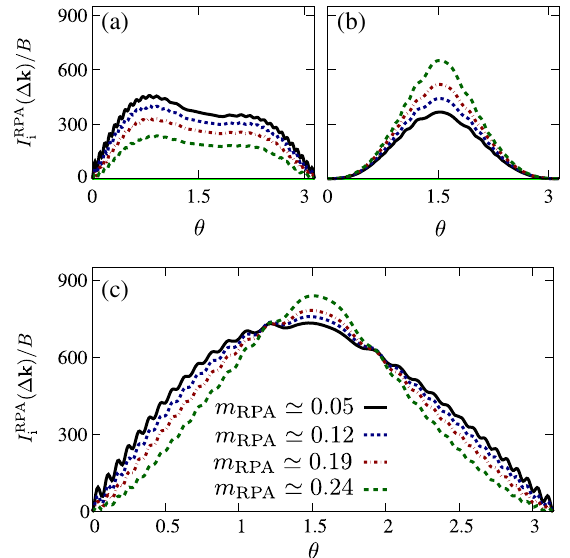
FIG. 13. Angular distribution of the inelastically scattered light intensity for different values of the interaction strength U at T ¼ 0 along the direction ϕ ¼ π = 4 . The calculations are based on RPA. We use the same parameters as in Fig. 11. Intensity contributions from (a) the density and longitudinal spin compo- nents, (b) the transverse spin component, and (c) total scattered light intensity. The scattered intensity increases with increasing magnetization near the perpendicular direction θ ∼ π = 2 since, because of the collective modes, the transverse spin component dominates the scattered